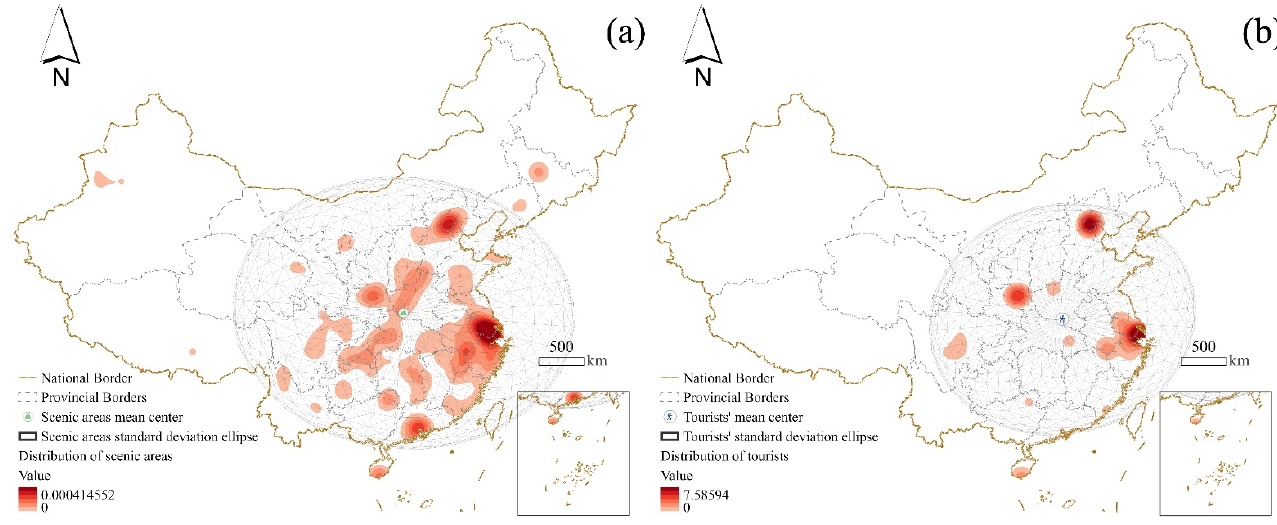
Figure 5. Spatial information on the distribution of scenic areas ( a ) and tourists ( b ) (kernel density and standard deviation ellipse).